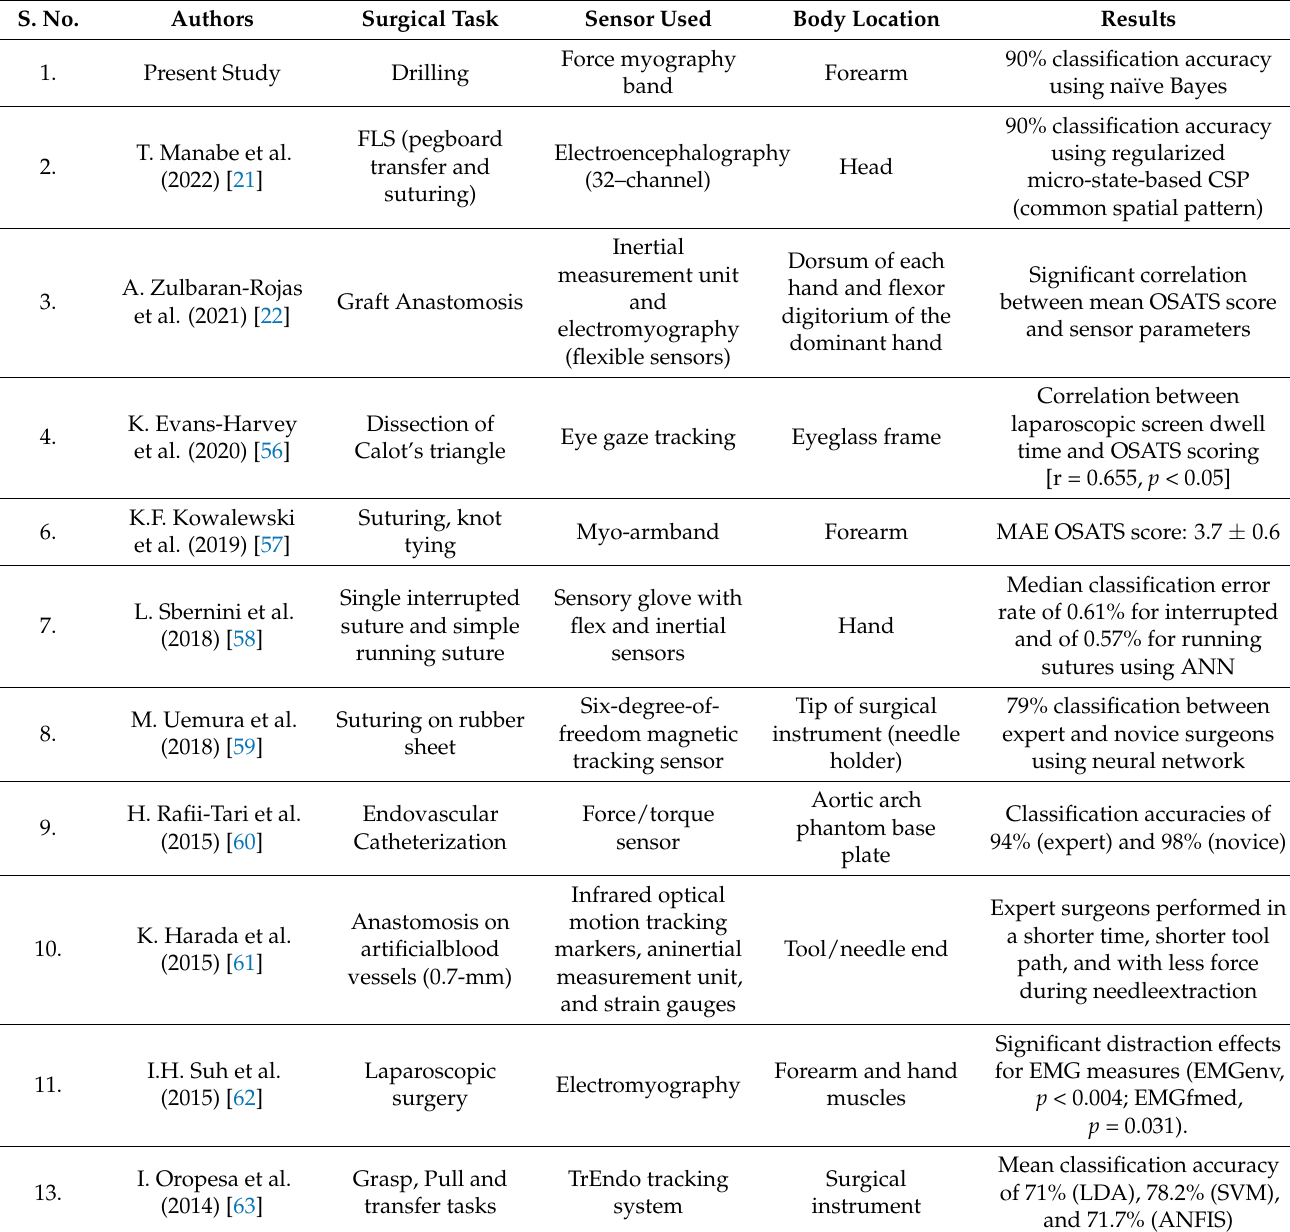
Table 4. Wearable sensors used for objective evaluation of surgical